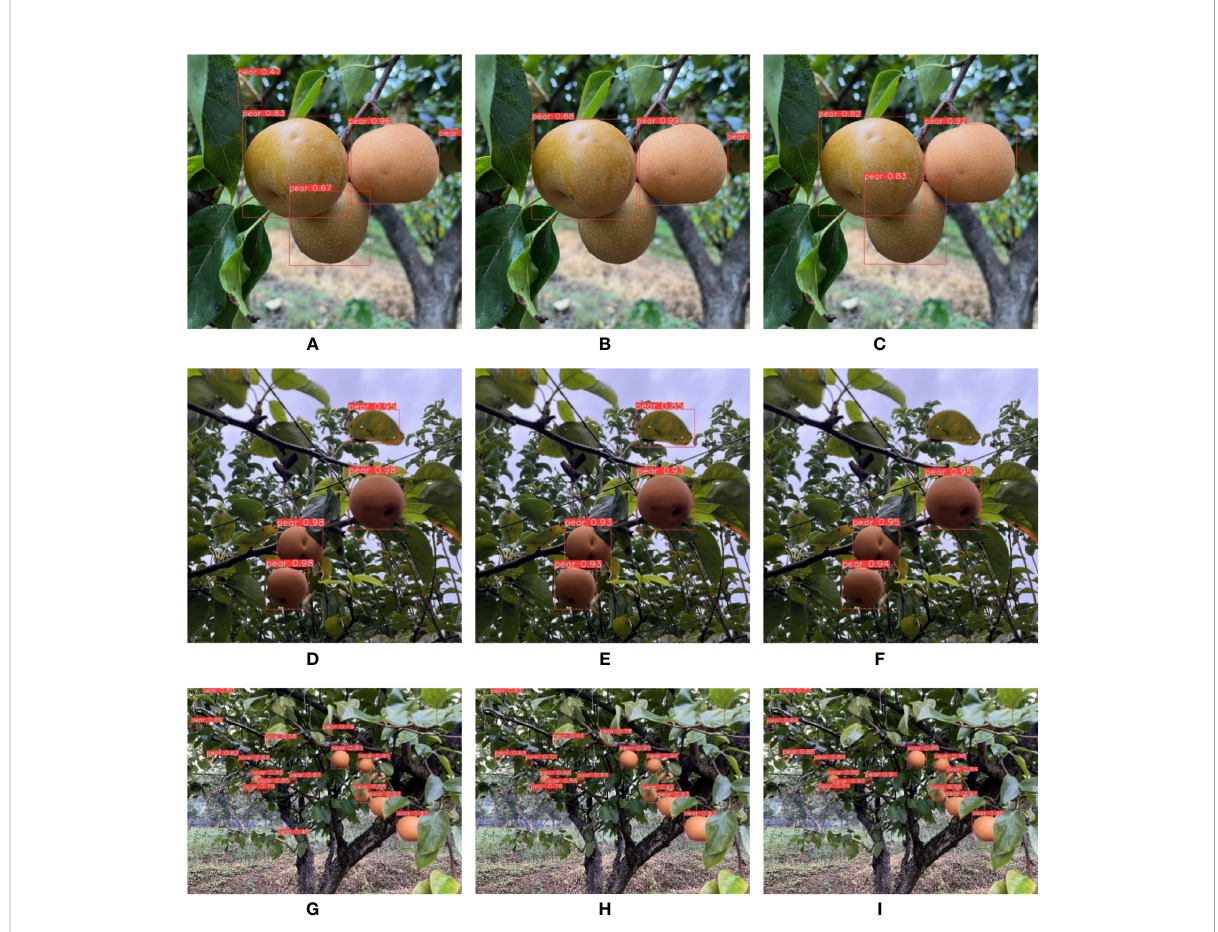
FIGURE 8 From left to right are the detection effects of YOLOv5s, MobileNet-YOLO and YOLO-P. (A – C) Uncomplicated background; (D – F) Moderately complex background; (G – I) Extremely complex